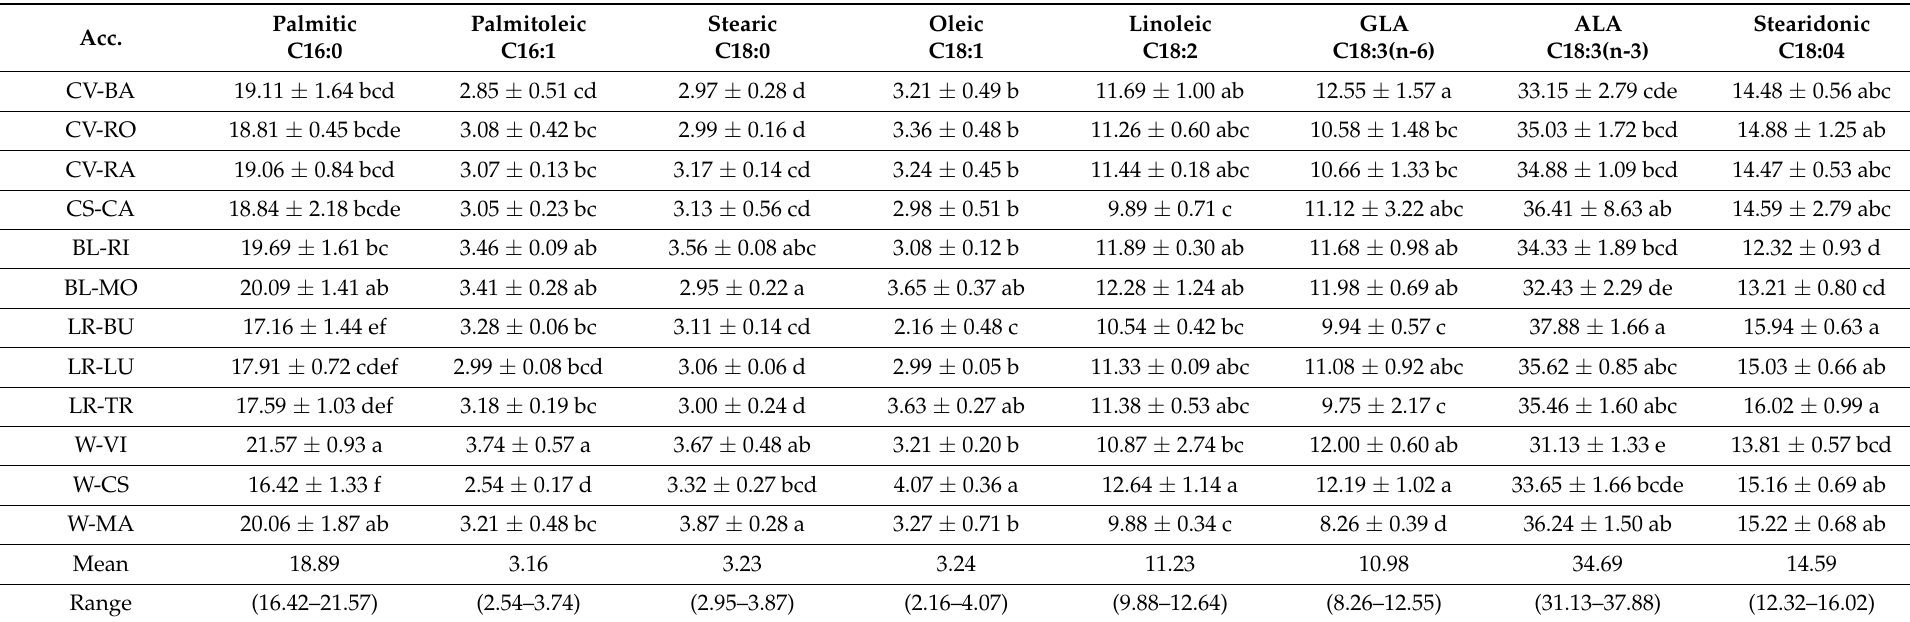
Table 4. Fatty acid composition, expressed in percentage of total fatty acids, of leaf blades of 12 borage accessions sampled at 120 days after sowing (Mean ± SD (n =